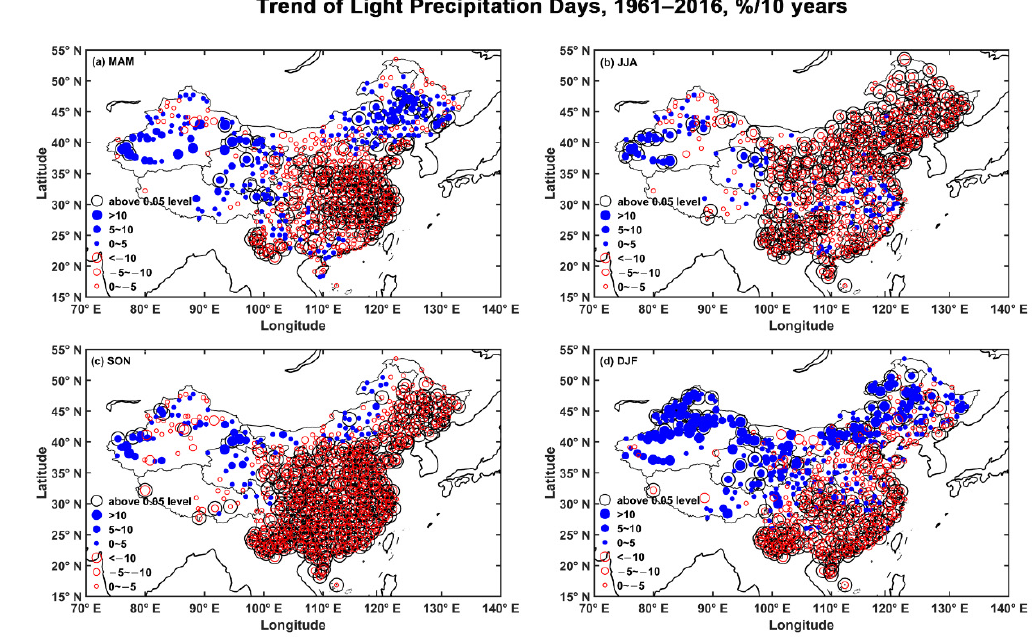
Figure 11. The spatial distributions about the temporal trends of light precipitation occurrence days (unit: % / 10 years) in ( a ) spring, ( b ) summer, ( c ) autumn, and ( d ) winter at 635 stations.